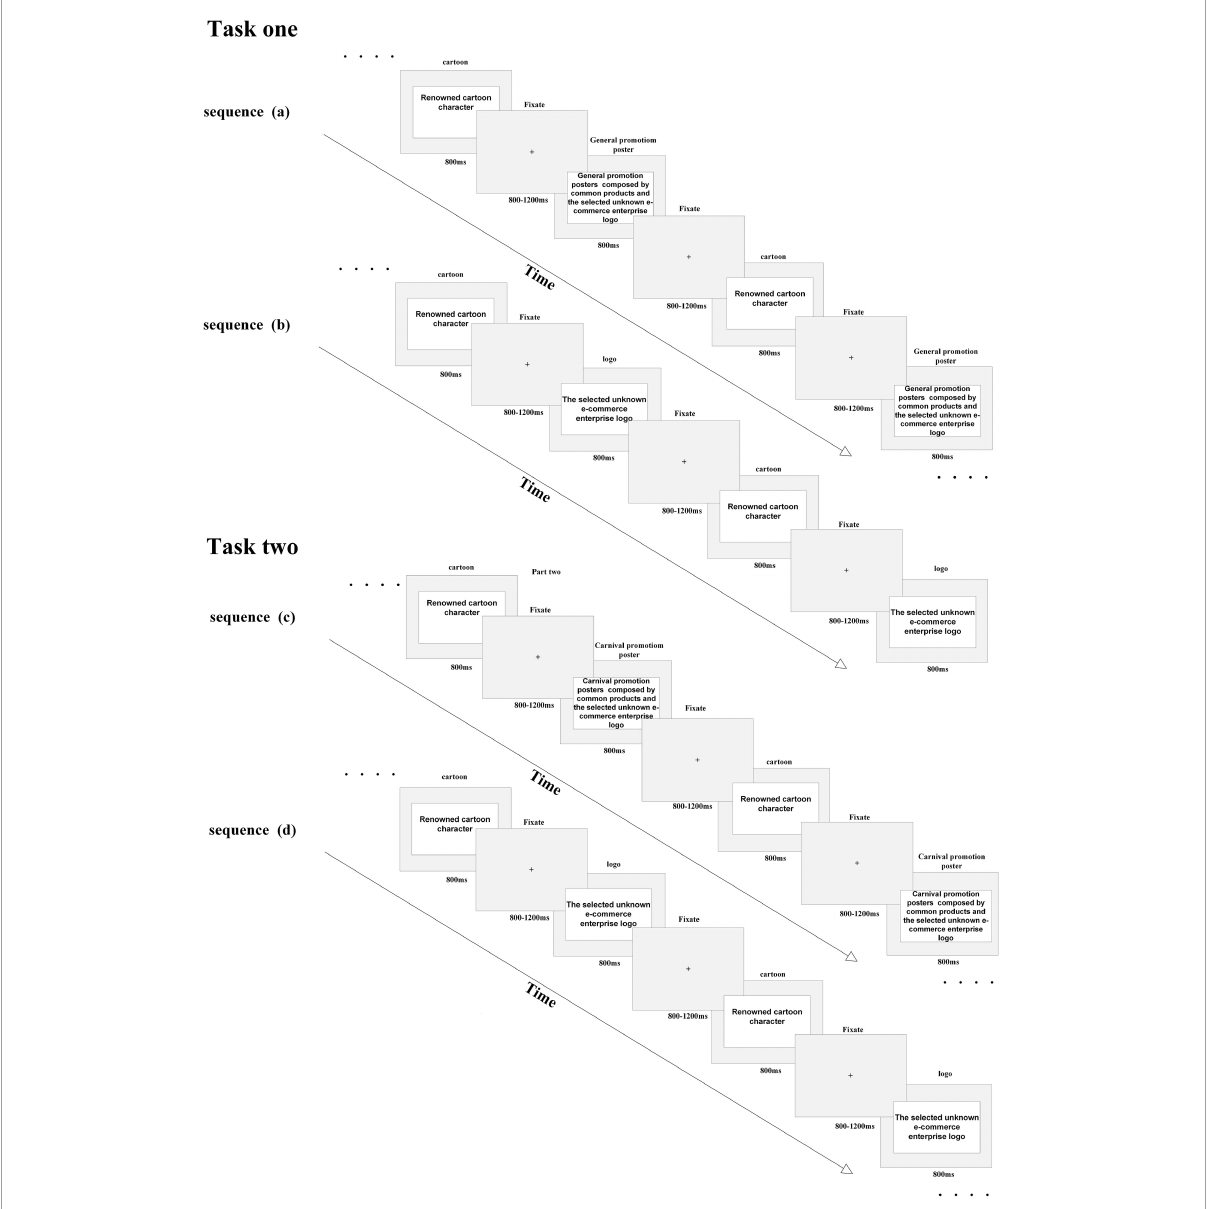
FIGURE1 Schematic drawing of the paradigm. Task 1 contains sequence A and sequence B. Sequence A was composed by cartoon pictures and general promotion posters with brand in an amended oddball paradigm. Sequence B was composed by cartoon pictures and e-commerce logo in an amended oddball paradigm. Task 2 contains sequence C and sequence D. Sequence C was composed by cartoon pictures and carnival promotion posters with brand i n an amended oddball paradigm. Sequence D was composed by cartoon pictures and e-commerce logo in an amended oddball paradigm. Subjects’ task was to identify and verbally report the number of cartoon character to researcher at the end of every sequence. Discount forms and discount magnitude, cash discount, discount coupon, time-limited sales promotions, and quantity discount used in general and carnival promotion posters, other promotion methods such as coupons, free gifts, and lottery were also used in posters. Overall, the promotion magnitude in carnival promotion posters was greater than in general promotion